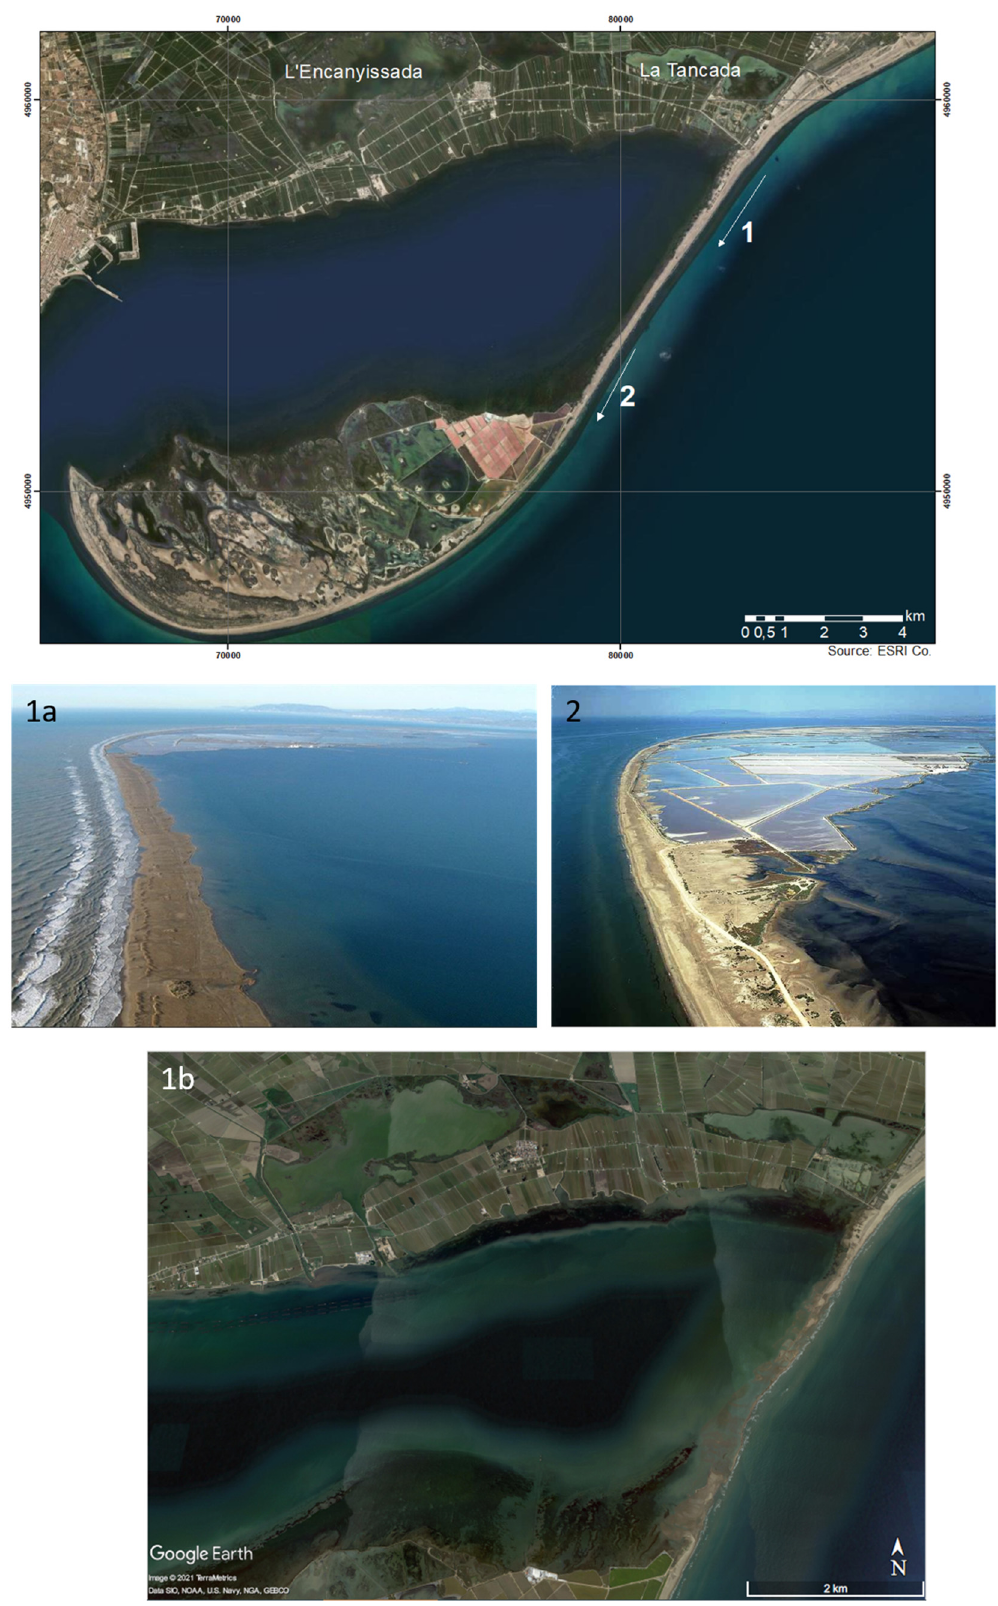
Figure 4. Images of the hemidelta south. ( 1a ) Trabucador bar; ( 1b ) Trabucador bar Break; ( 2 ); ( 3 ) Trinitat saltworks and La Banya Spit. (Source: General view: ESRI Co.; Photographs 1a and 2: Guide of beaches of the Ministry for the Ecological Transition and the demographic challenge; Image 1b: Google Earth).